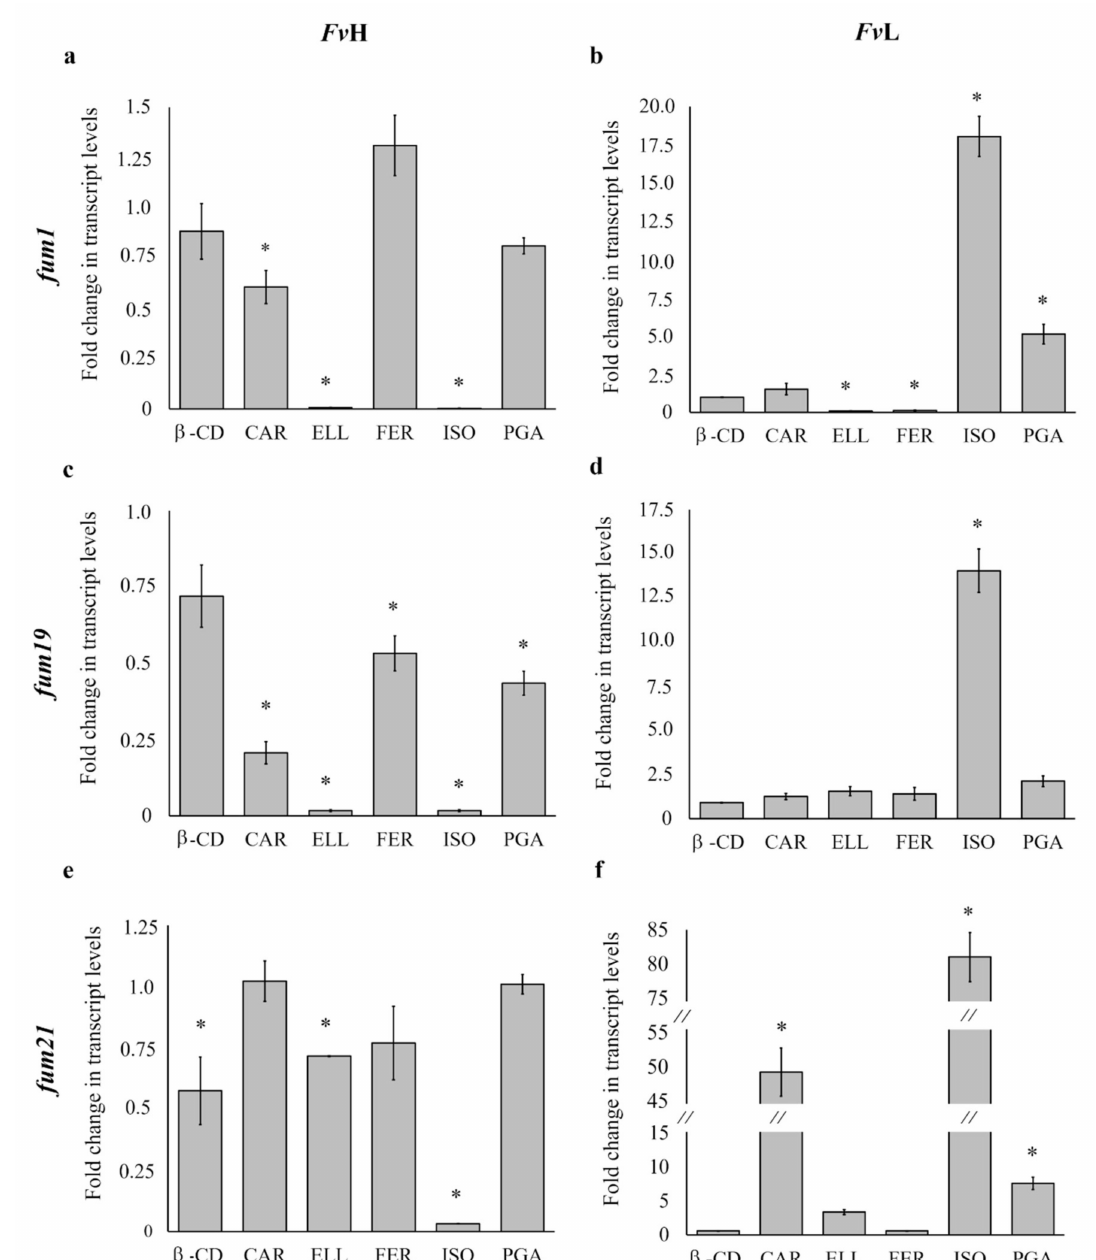
Figure 2. Fold changes on fum gene expression observed on Fv H (figures on the left; a : fum1 ; c : fum19 ; e : fum21 ) and Fv L (figures on the right; b : fum1 ; d : fum19 ; f : fum21 ) in response to selected 1.0 mM phenolic compound treatments with respect to values observed on untreated cultures. Due to data normalization, the expression level calculated for untreated control was set to 1.0. Bars represent the average value ± standard error. Bars with asterisks (*) are significantly different to untreated control according to Kruskal–Wallis and Dunn’s test ( p <